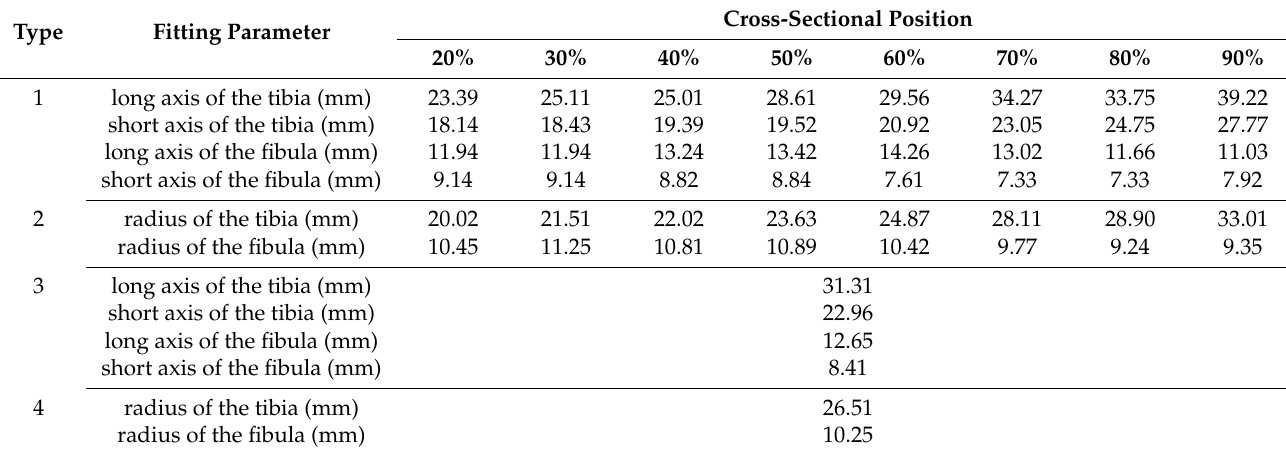
Table 1. Key design-parameters of the four bionic tubes.